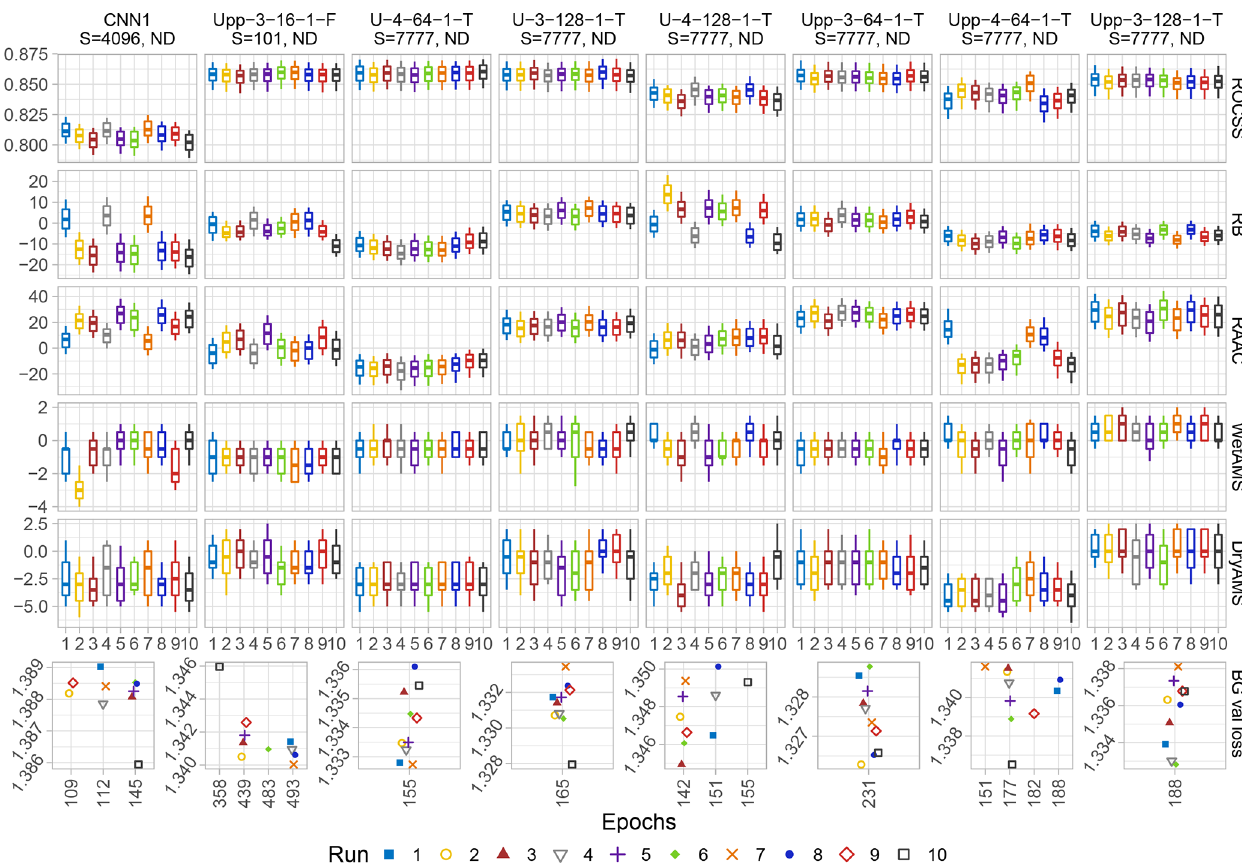
Figure 6. Similar to Fig. 5 but for other architectures under non-deterministic conditions only. The last row depicts the minimum value achieved by the Bernoulli Gamma loss function (BG val loss) during training and the number of epochs needed to train the models. Note that the x axis of the last row is not to scale and the symbols are avoiding other ones on similar positions to ease its readability, thus refer to the closest abscissa grid line to interpret its